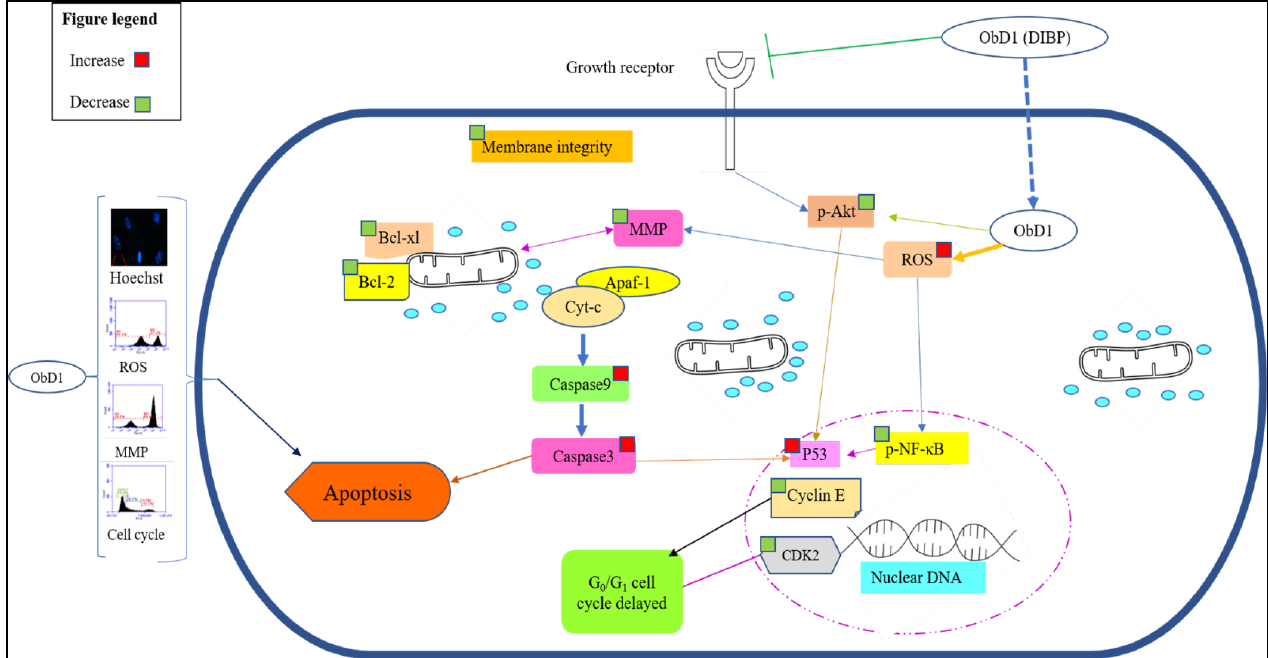
Figure 16. Schematic diagram showing the effect of BDCe fraction isolated from Obea of Onosma bracteata -induced apoptosis in osteosarcoma (MG-63 cells).